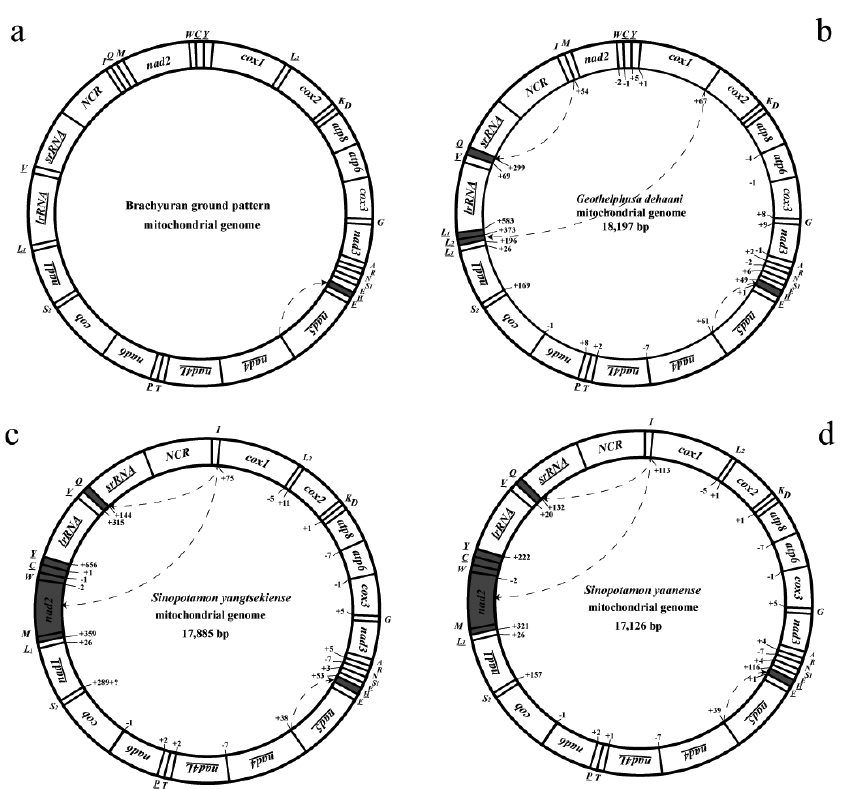
Figure 1. Mitochondrial genome sequenced in the present study. Gene order and sizes are shown rela- tive to one another, including non-coding regions. Protein-coding genes encoded on the light strand are underlined. Transfer RNA (tRNA) genes encoded on the light strand are underlined. Each tRNA gene is designated by a single-letter amino acid code, except L1 ( trnLeu (CUN) ), L2 ( trnLeu (UUR) ), S1 ( trnSer (AGN) ) and S2 ( trnSer (UCN) ). Numbers inside circles represent the size of the non-coding region separating two adjacent genes or the amount of shared nucleotides between two overlapping genes. The translocations of gene or gene block are shaded